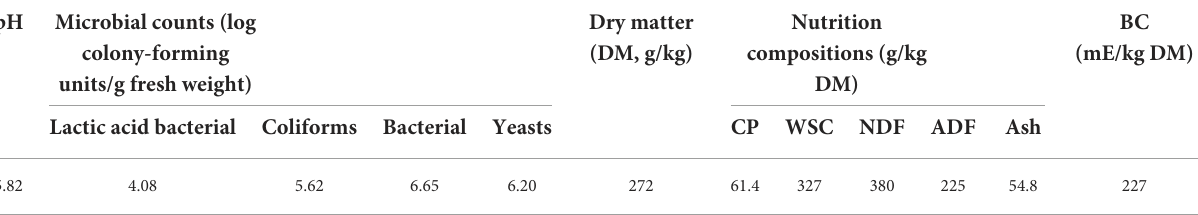
TABLE 1 Characteristics of sweet sorghum before ensiling ( n = 4).